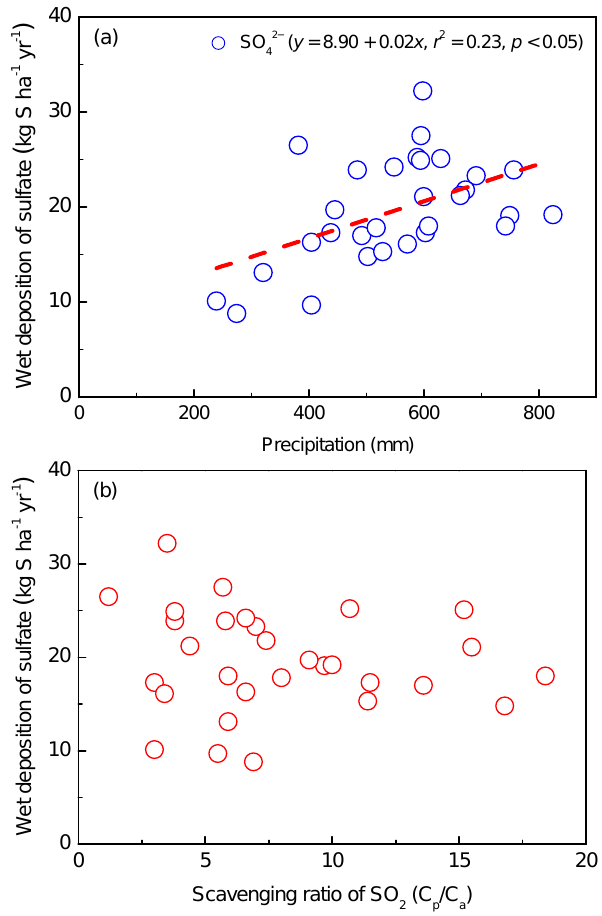
Fig. 4. Annual wet deposition flux of sulfur vs. precipitation amount (a) and scavenging ratios of SO 2 (b) at the ten selected sites in Northern